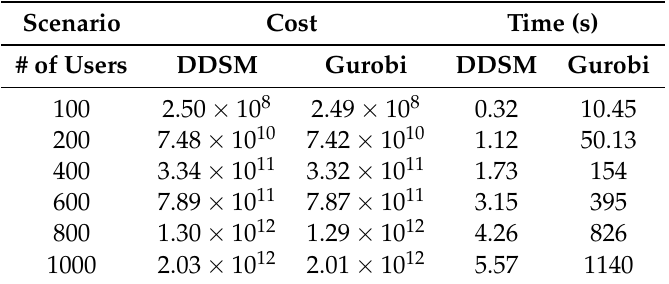
Figure 6. Evaluation of Algorithm 2 using imperfect information of renewable energy (note, renewable energy is abbreviated as R.E. in the figure). Table 5. Optimality and speed of the DDSM